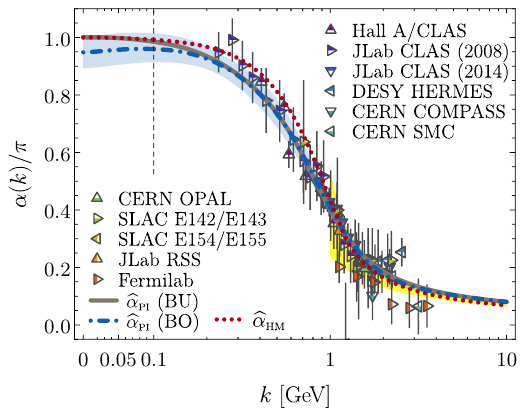
Figure 2. Renormalisation-group-invariant dressed-quark mass Figure 1. Dot-dashed [blue] curve: process-independent function, M ( p ) in Eq.(9): solid curves – continuum nonper- running-coupling α PI ( k 2 ) [6]: the shaded [blue] band bracketing turbative results [16, 17]; “data” – numerical simulations of this curve combines a 95% confidence-level window based on lQCD [18]. The current-quark of perturbative QCD evolves existing lQCD results for the gluon two-point function with an into a constituent-quark as its momentum becomes smaller. The error of 10% in the continuum analysis of relevant ghost-gluon constituent-quark mass arises from a cloud of low-momentum dynamics. Solid [black] curve, updated result [9]. Also depicted, gluons attaching themselves to the current-quark. This is DCSB, world’s data on the process-dependent coupling α g , defined via 1 the essentially nonperturbative e ff ect that generates a quark mass the Bjorken sum rule, the sources of which are listed elsewhere from nothing ; namely, it occurs even in the absence of a Higgs [6]. The shaded [yellow] band on k > 1GeV represents α g ob- 1 mechanism. The size of M (0) is a measure of the magnitude tained from the Bjorken sum by using QCD evolution to extrapo- of the QCD scale anomaly in n = 1-point Schwinger functions late high- k 2 data into the depicted region [14]; and, for additional [19]. Moreover, experiments on Q 2 ∈ [0 , 12]GeV 2 at the mod- context, the dashed [red] curve is the e ff ective charge obtained in ern Thomas Je ff erson National Accelerator Facility (JLab) will a light-front holographic model [15]. The k-axis scale is linear to be sensitive to the momentum dependence of M ( p ) within a do- the left of the vertical dashed line and logarithmic otherwise. main that is here indicated approximately by the shaded